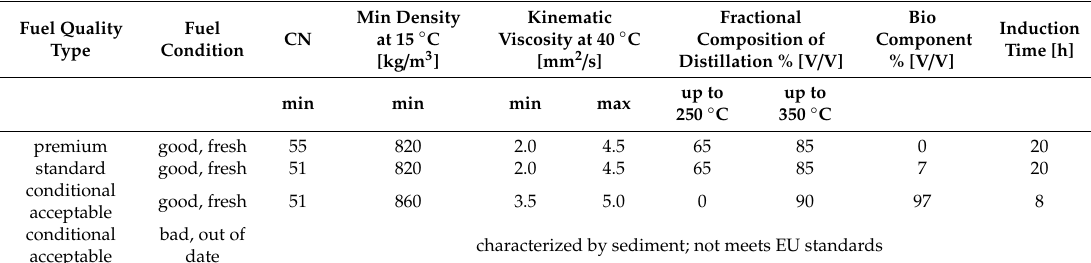
Fuels type and condition versus basic petrochemical parameters of fuels used to sensor